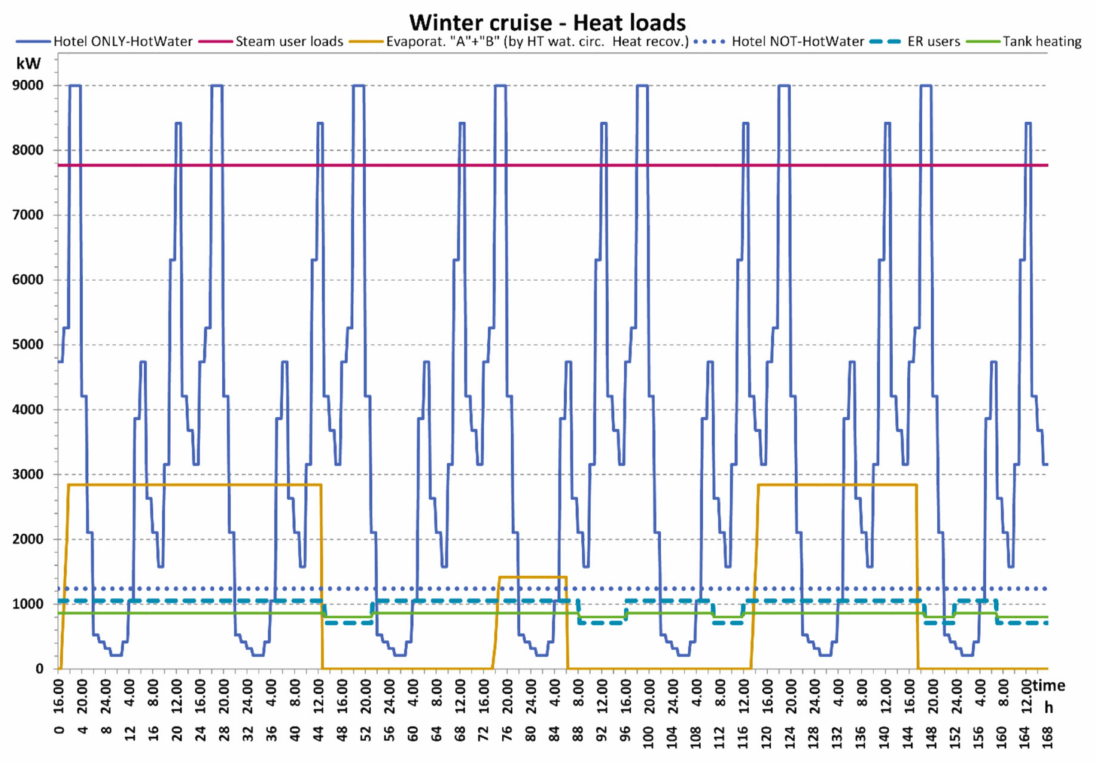
Figure 3. Thermal demand during the winter cruise.